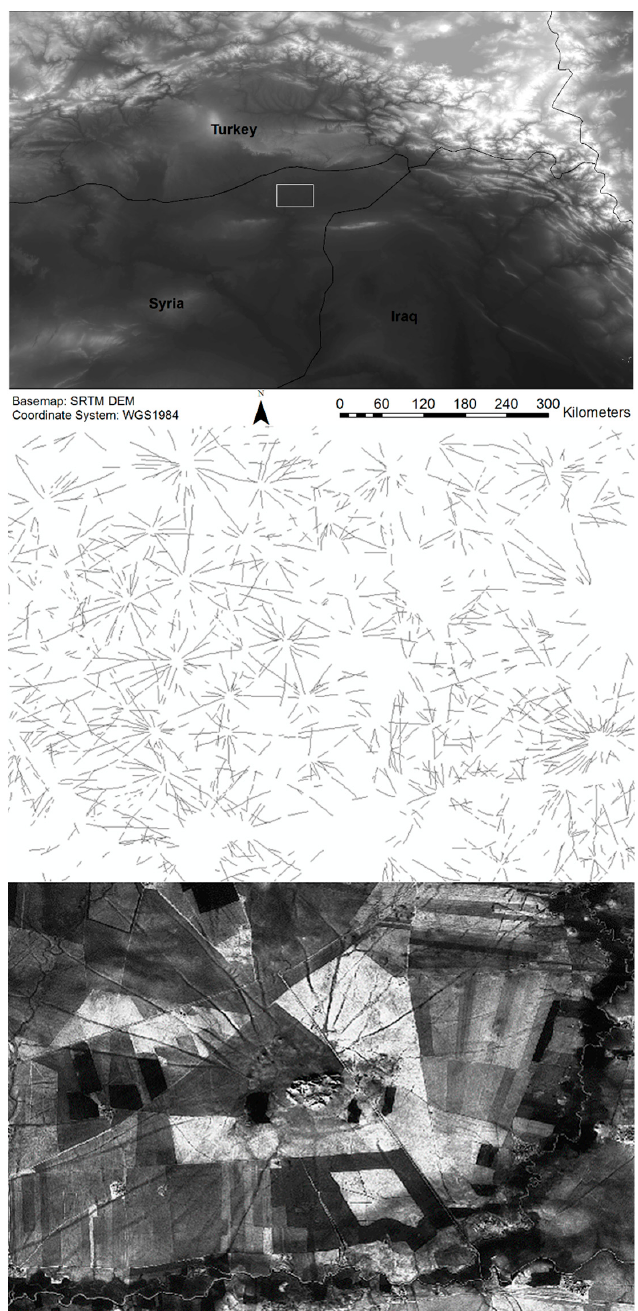
Figure 3. Hollow ways in the Near East have distinctive characteristics in tone (below) and morphology/shape (middle), often radiating outwards from sites, as seen in this example from the North Jazira of Tell Brak. The middle image is a portion of the hollow ways digitized by Jason Ur in the North Jazira [7]. The lower image is a view of Tell Brak from CORONA imagery.